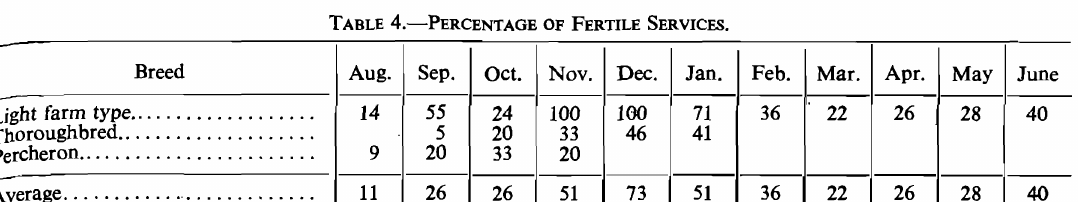
TABLE 4.-PERCENTAGE OF FERTILE